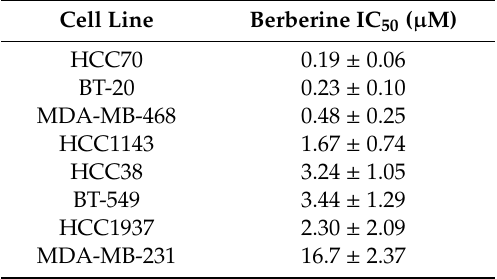
Figure 1. Effect of berberine’s treatment on triple negative breast cancer (TNBC) cell proliferation. TNBC cell lines were seeded and treated with berberine. The cell viability was measured by MTT assay. ± Standard Deviation of three independent experiments carried out in triplicate. Table 1. IC 50 (µM) values of berberine on TNBC cell lines ± standard deviation.